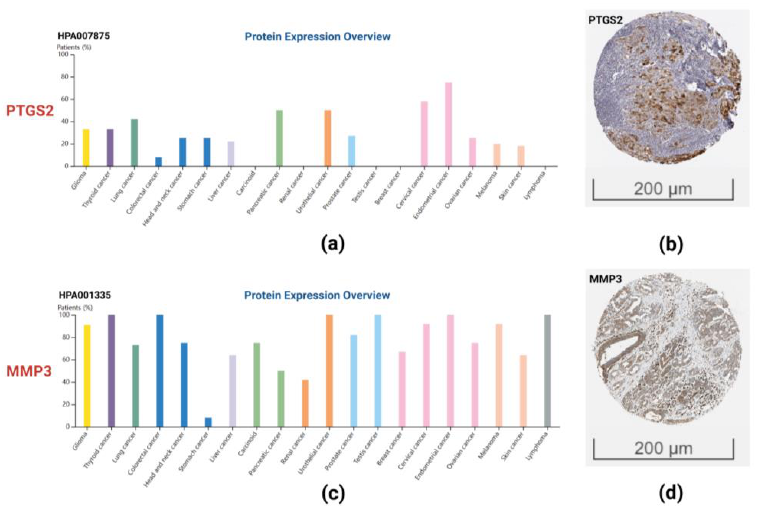
Figure 10. Expressions of PTGS2 in various cancer tissues ( a ), PTGS2 shows high staining in HSNC ( b ), expressions of MMP3 in various cancer tissues ( c ), and MMP3 also shows strong staining in HSNC ( d